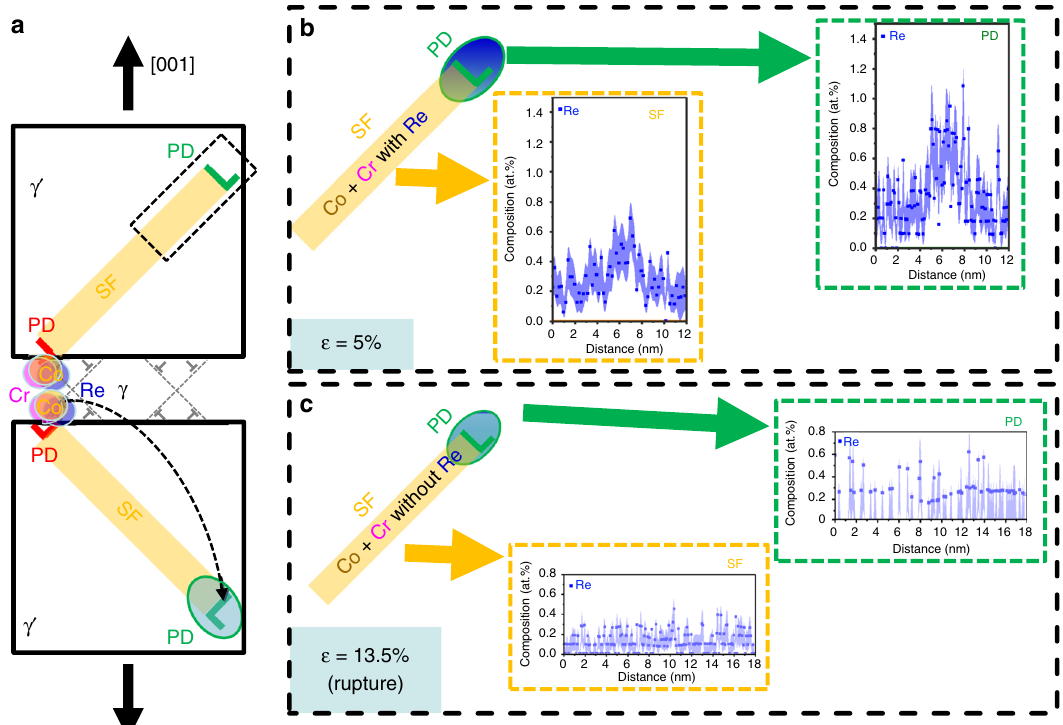
Fig. 9 Schematic evolution of element enrichment (i.e., Re) at SF and PDs during creep. a Schematic showing the generation of SFs by PDs inside of γ ‘ phases with segregation in the dislocations in the γ phase. Further analysis focuses on the dashed rectangle region of a PD and associated SF. b 5% creep strain: Re Cottrell atmosphere around PD and less enrichment of Re in the SF. c Rupture: decreased amount of Cr and Co segregating to the PDs compared to the 5% creep stage, no Re enrichment observed and less dragging effect at this stage. More information see